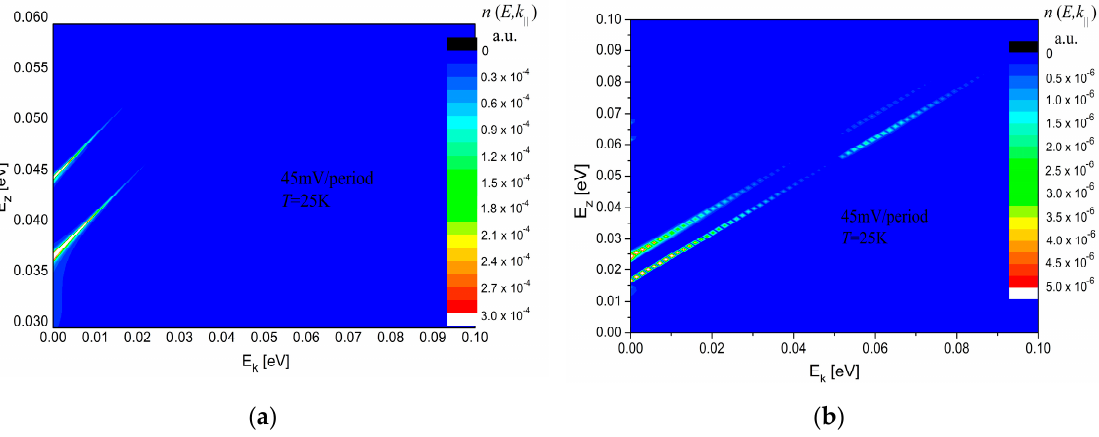
Figure 9. The energy maps of k -resolved occupation functions n ( E , k || ): ( a ) for the fixed electron scattering model with the Büttiker probes applied, ( b ) with the LO-phonon scattering process taken into account. The calculations were performed for the structure no. 2, described in [24] at assumed T = 25 K.